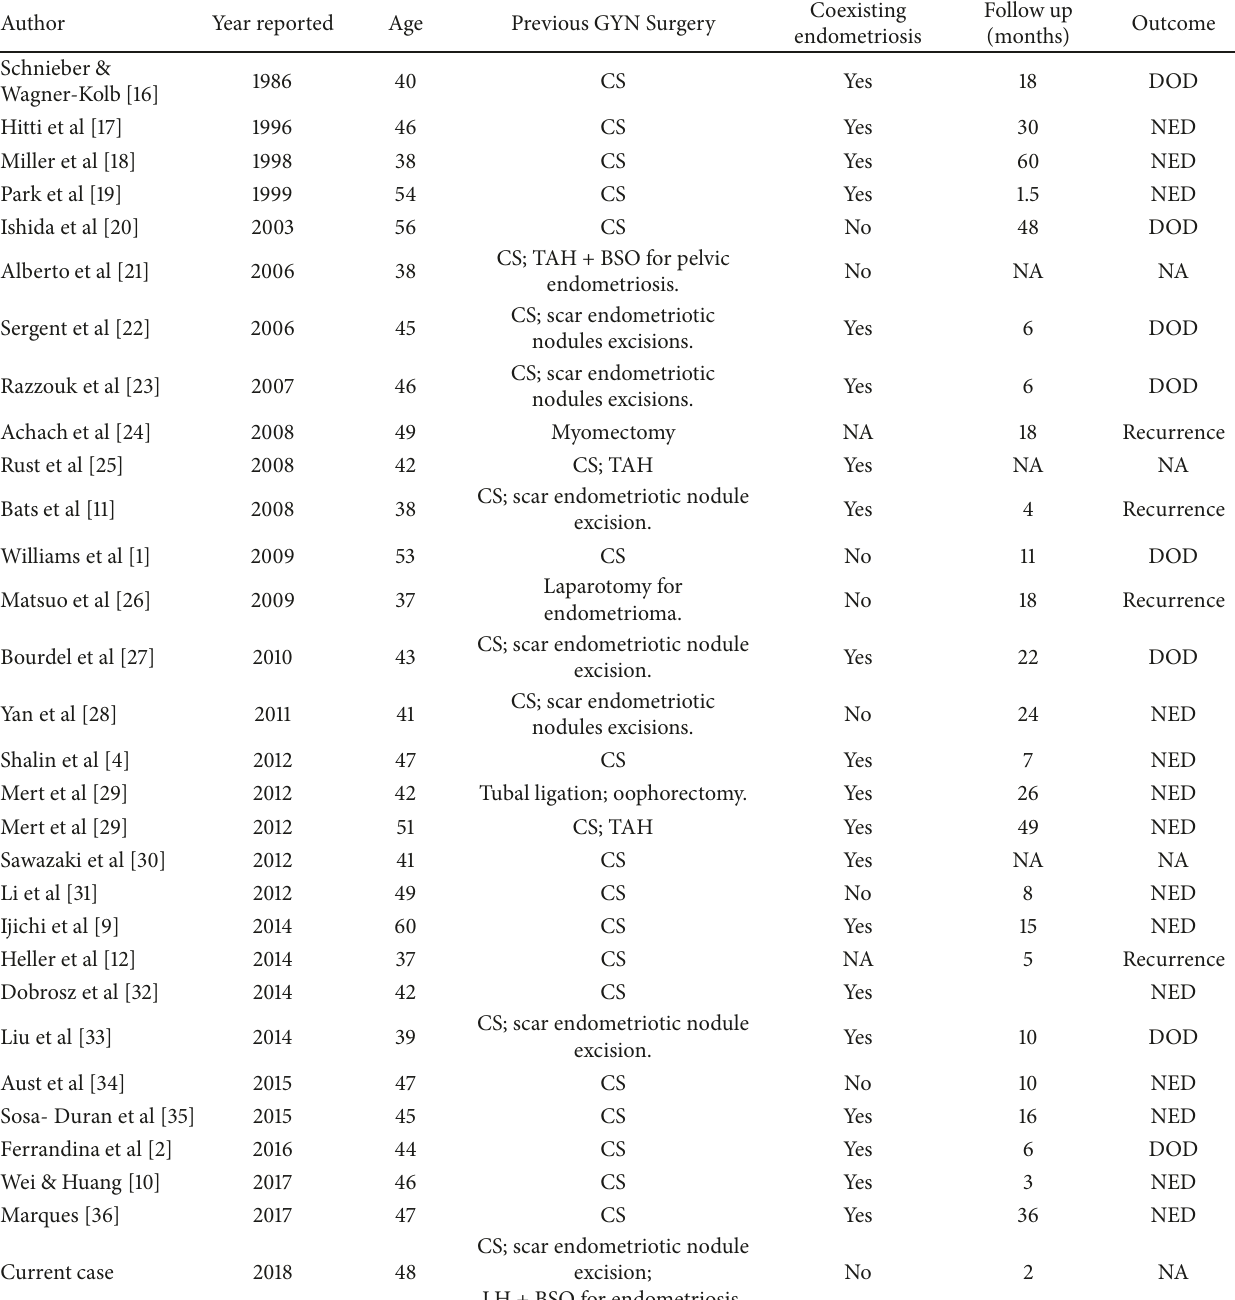
Table 2: Clear cell carcinoma arising in abdominal wall endometriosis